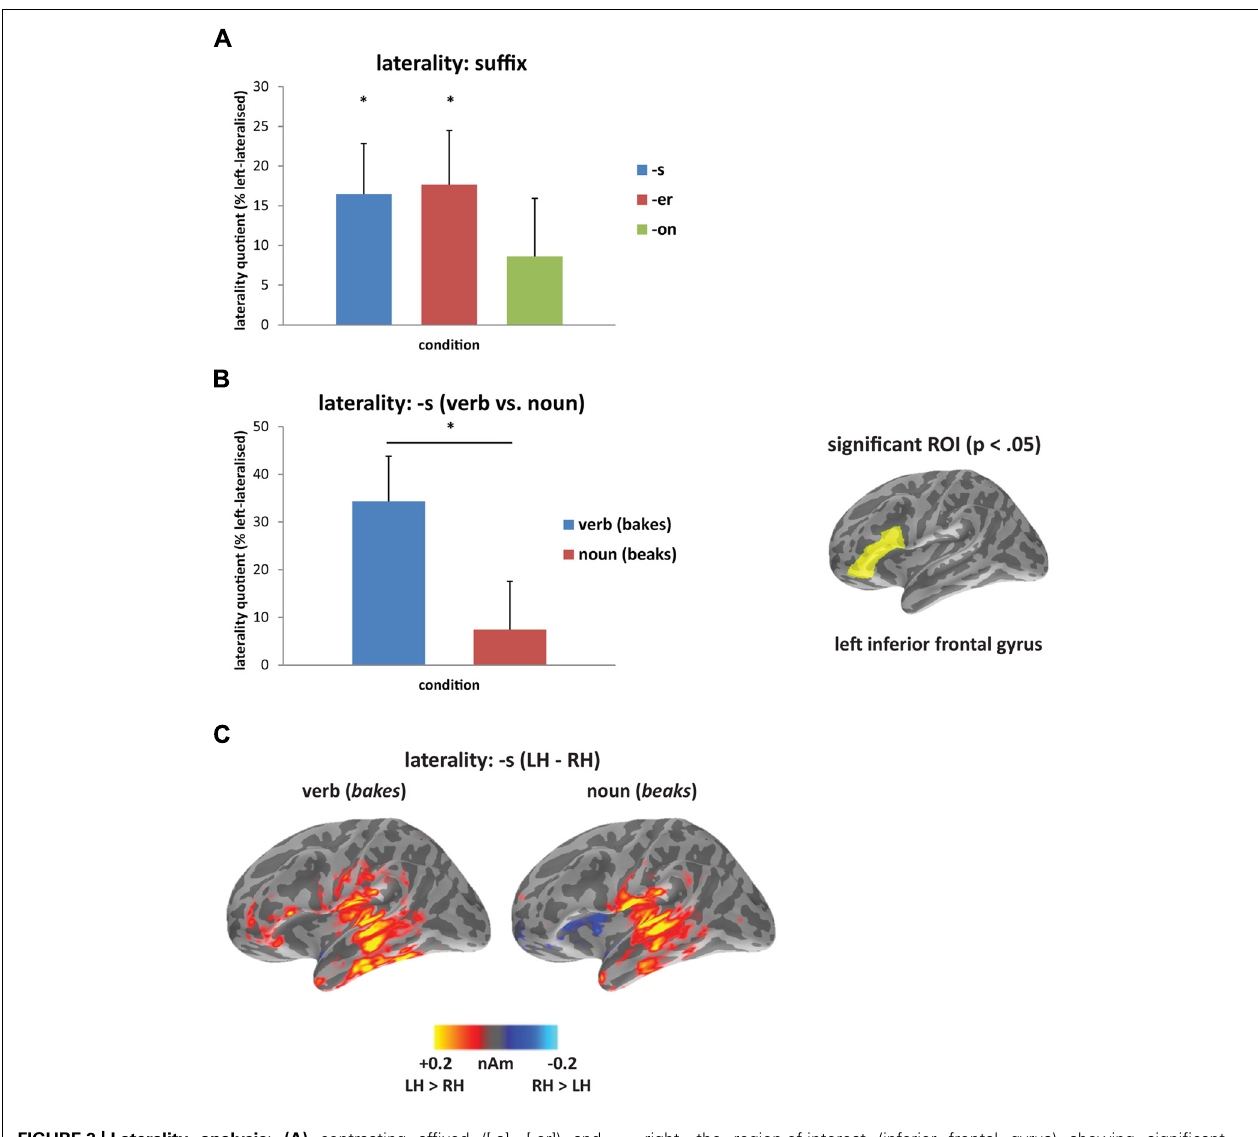
right, the region-of-interest (inferior frontal gyrus) showing significant lateralization. (C) Source activation for [-s] deviants from 160 to 240 ms, displaying the difference in amplitude between left and right hemispheres (LH minus RH at each vertex; yellow/red indicates greater left hemisphere activity; blue indicates greater right hemisphere